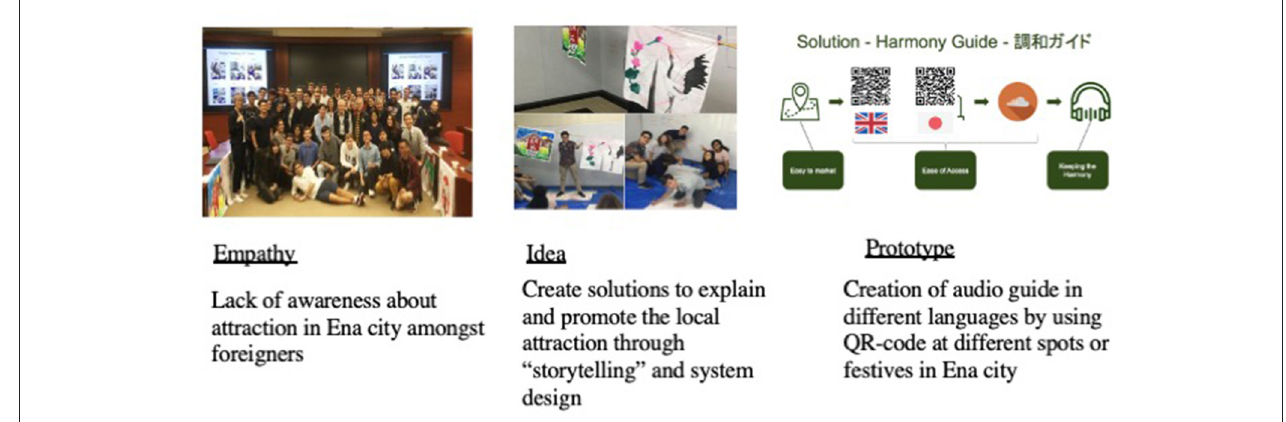
FIGURE 2 | “Harmony Audio” system for Ena